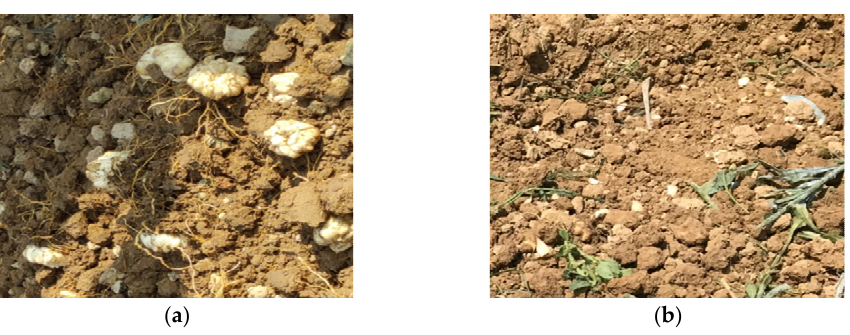
Figure 3. Photos of damaged and undamaged lily fruit samples. ( a ) Undamaged lily fruit samples; ( b ) Damaged lily fruit samples.